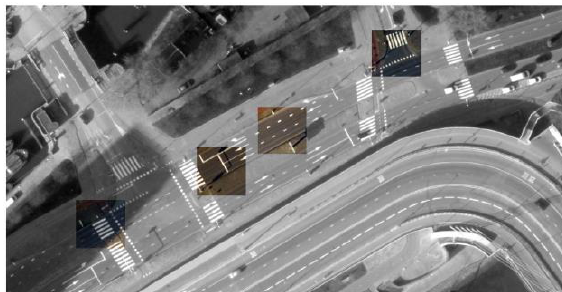
Figure 4 Four subsets of a typical urban scene (coloured tiles from scene 1 on the left to scene 4 on the right)